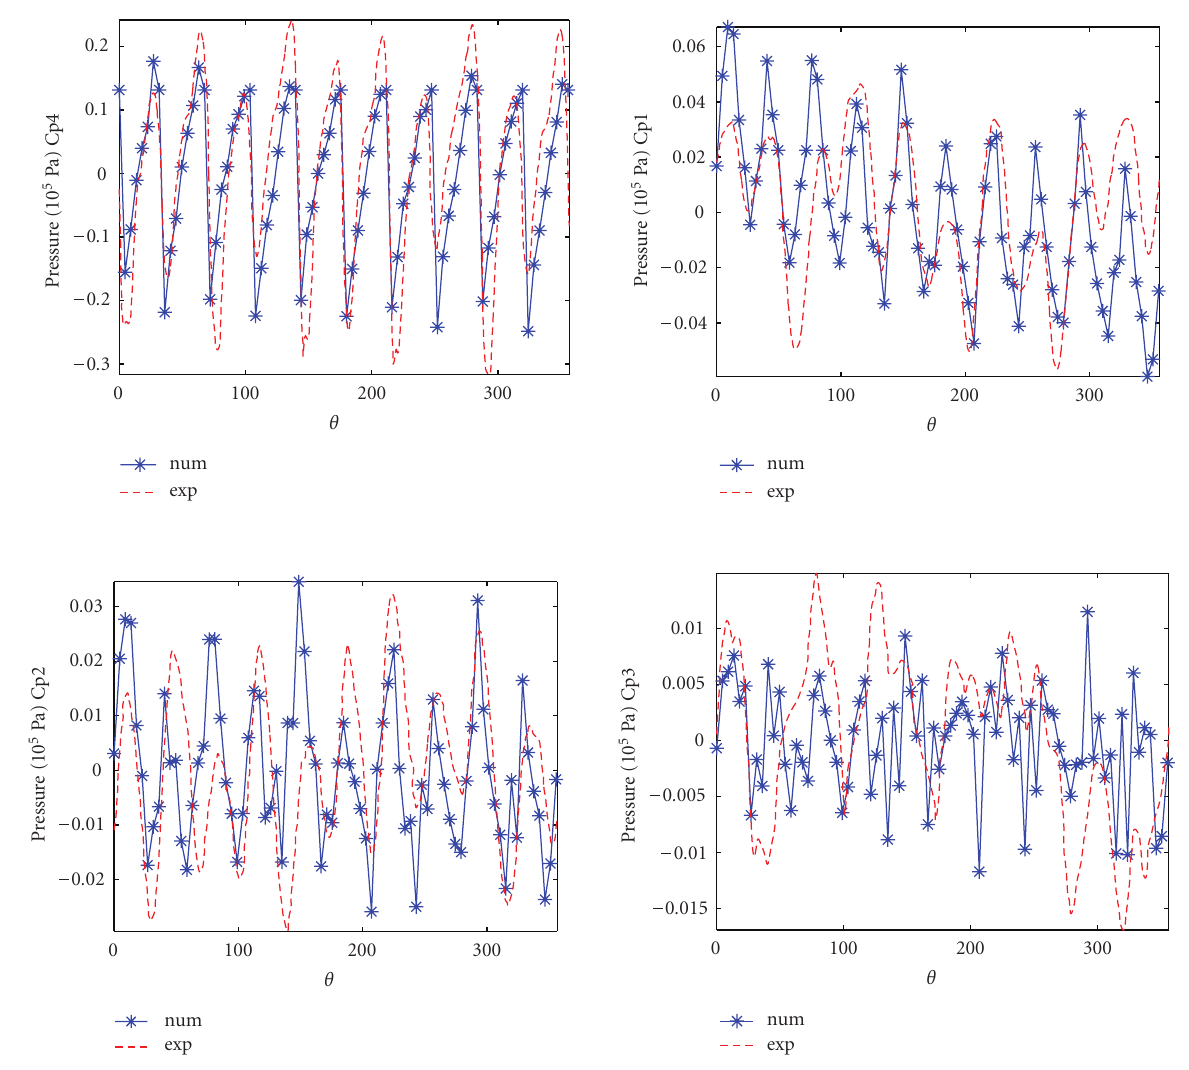
Figure 19: Computed and experimental pressure fluctuations over one impeller revolution—splittered impeller—sensors Cp4, Cp1, Cp2, and Cp3 at BEP; num = numerical, exp =